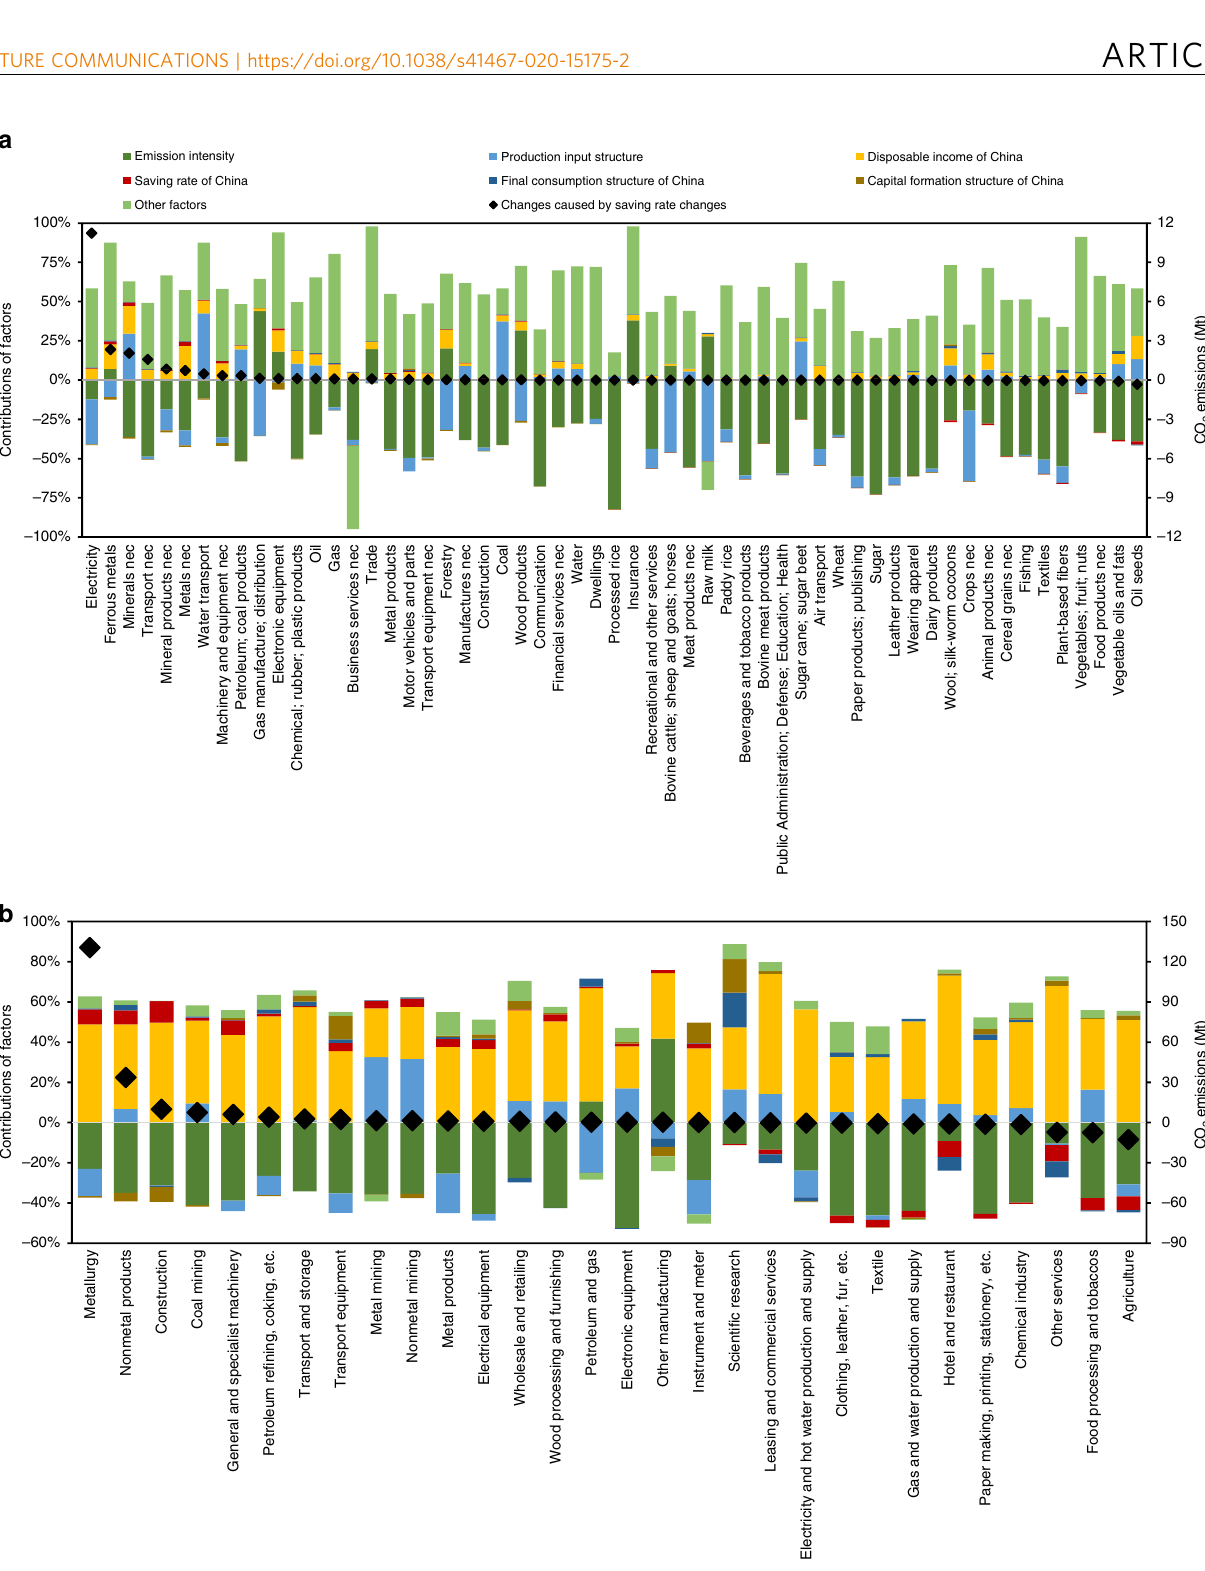
Fig. 1 Relative contributions of socioeconomic factors to global industrial CO 2 emission changes during 2007 – 2012. a , b show the relative contributions of socioeconomic factors to global industrial CO 2 emission changes in sectors of nations other than China and sectors of China, respectively. The red portion in each bar indicates the relative contribution of saving rate changes in China during 2007 – 2012. The mark (black diamond) indicates the amount of CO 2 emission changes caused by saving rate increments in China during 2007 –